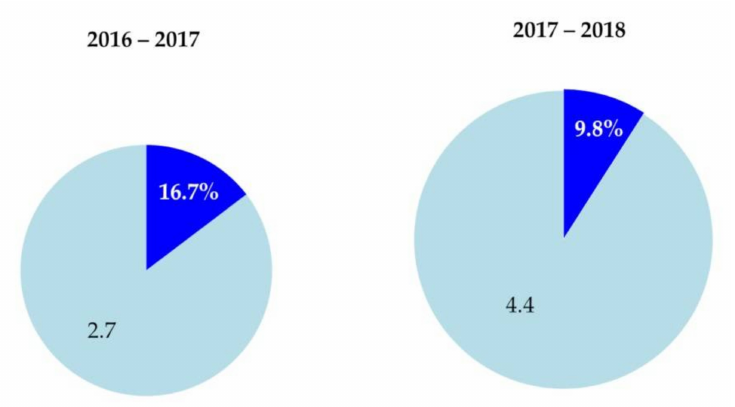
Figure 7. AMDE contribution (dark blue) in total annual Hg wet deposition in Nadym (light blue), where the ratio of the circle sizes corresponds to the ratio of the annual Hg wet deposition